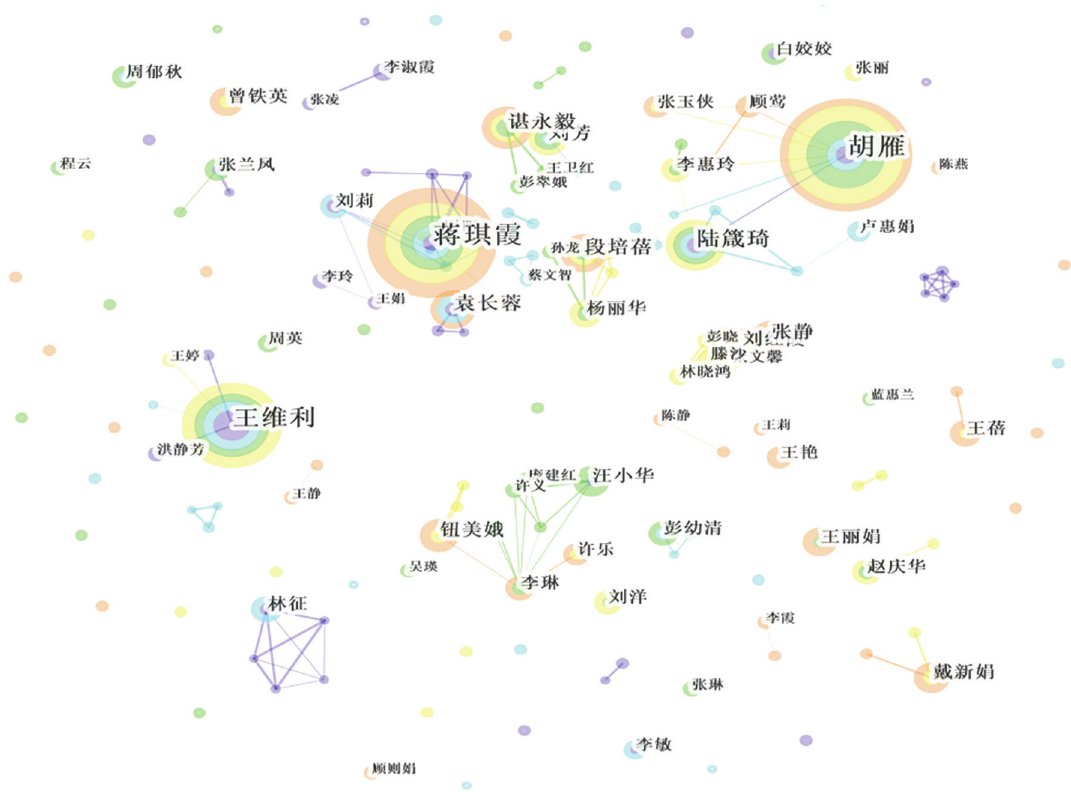
Figure 1. The mapping knowledge domains of author